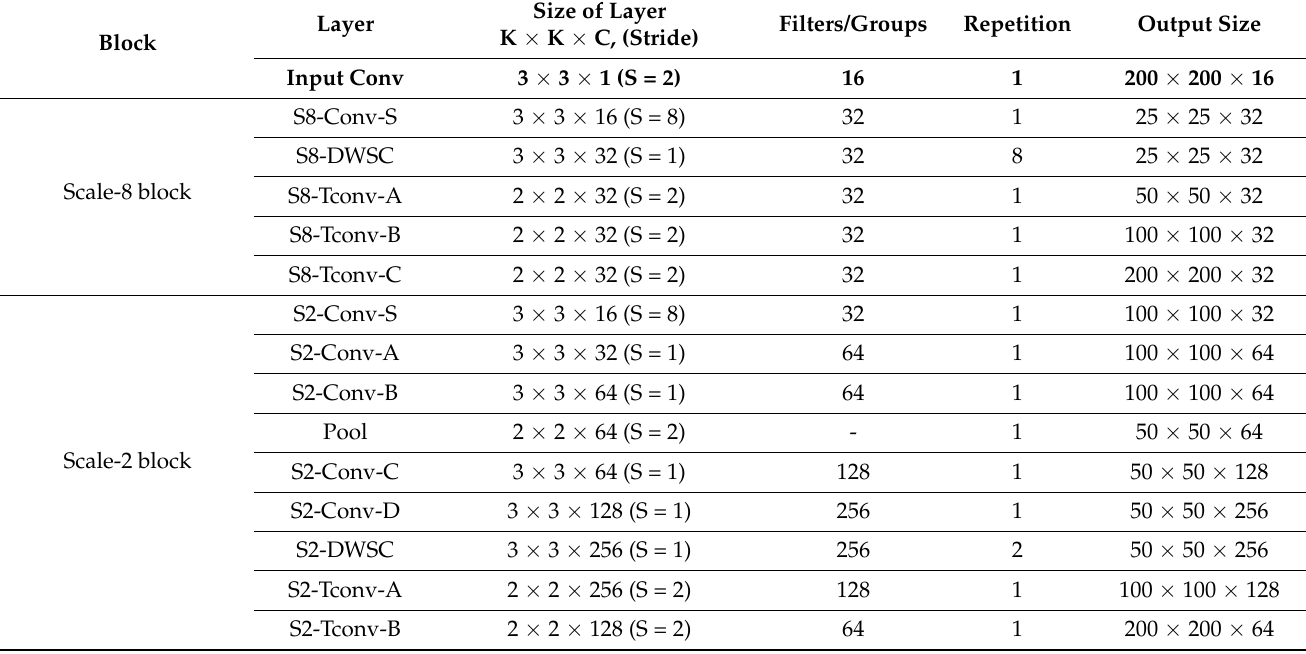
Table 1. Details of feature map sizes for MASS-Net